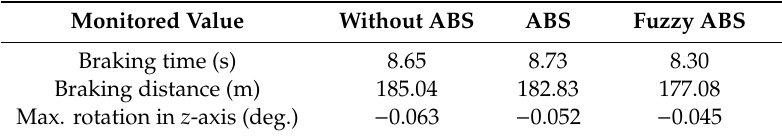
− 2.14 Figure 13 and Table 6 show the results of braking test runs at speed 140 km/h. ( a ) ( b ) ( c ) Figure 13. Test on road with combined adhesion at speed 140 km/h—( a ) Speed curve; ( b ) Braking distance; ( c ) Vehicle rotation.